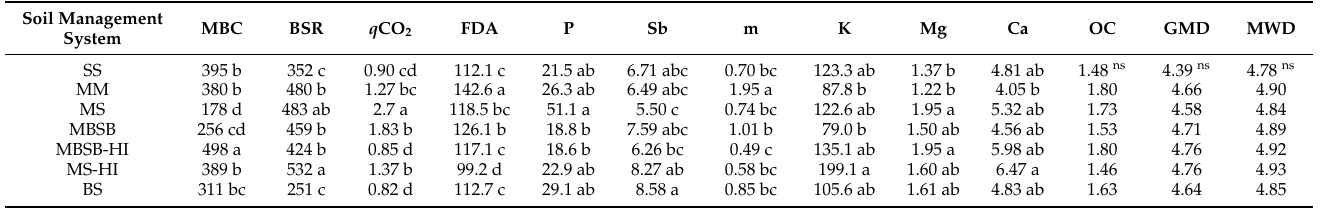
Table 3. Physical, chemical, and microbiological indicators evaluated in crop interrows for each